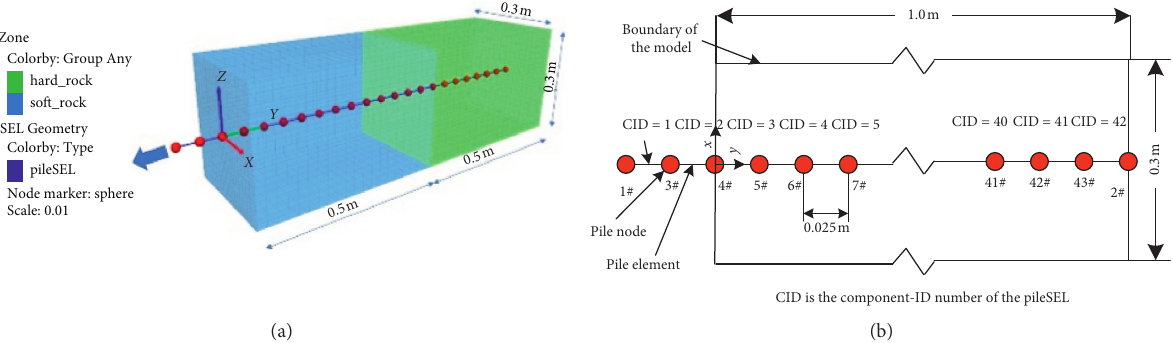
Zone Colorby: Group Any hard_rock soft_rock